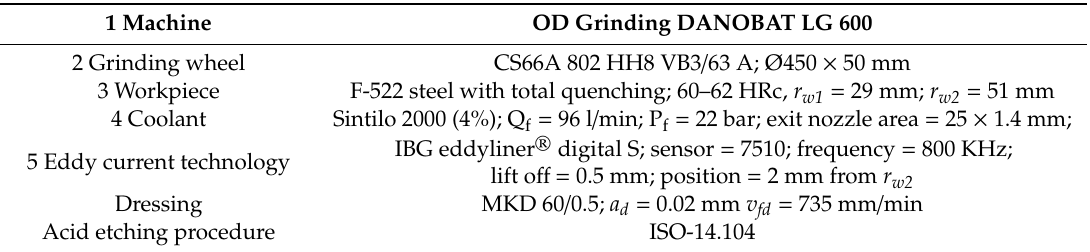
Table 2. System components and process conditions for experimental analysis and model validation.